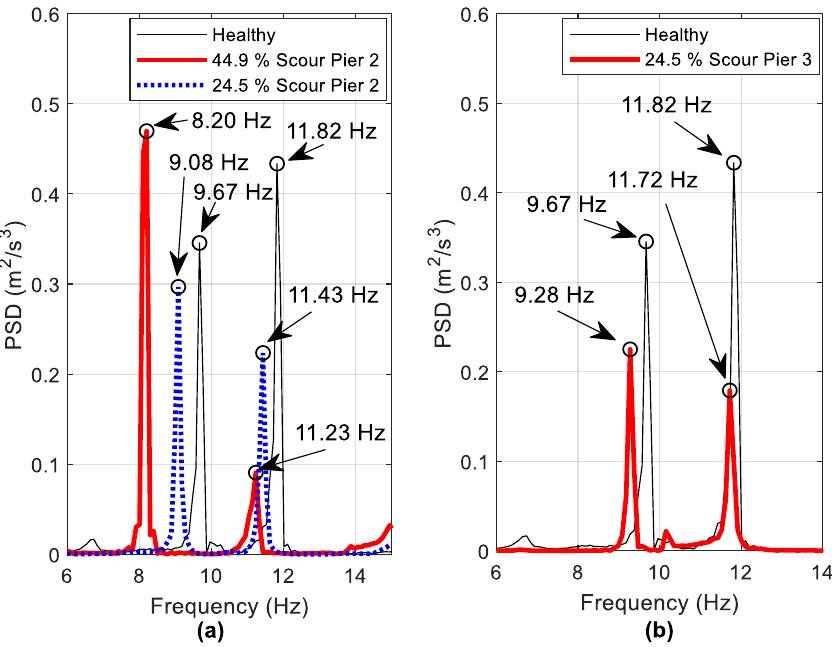
Figure 14. Energy harvester voltage data — ( a ) Harvester voltage, ( b ) PSD of free-vibration voltage data.